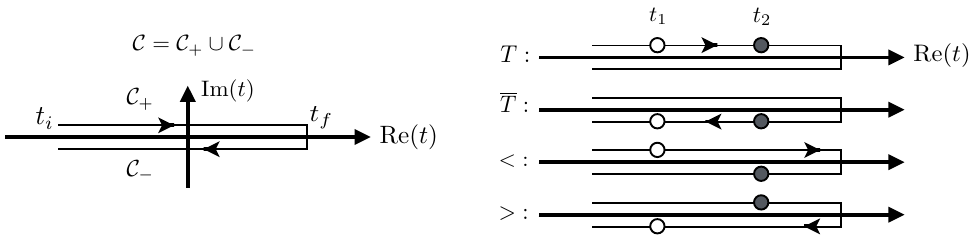
Figure 2 . Left panel: the CTP time contour. The time runs from an initial time t time t f and then returns to t i . Right panel: time ordered ( T ), anti-time ordered ( T ), t 1 and t 2 t 1 ( > ) paths de(cid:12)ned in the CTP !